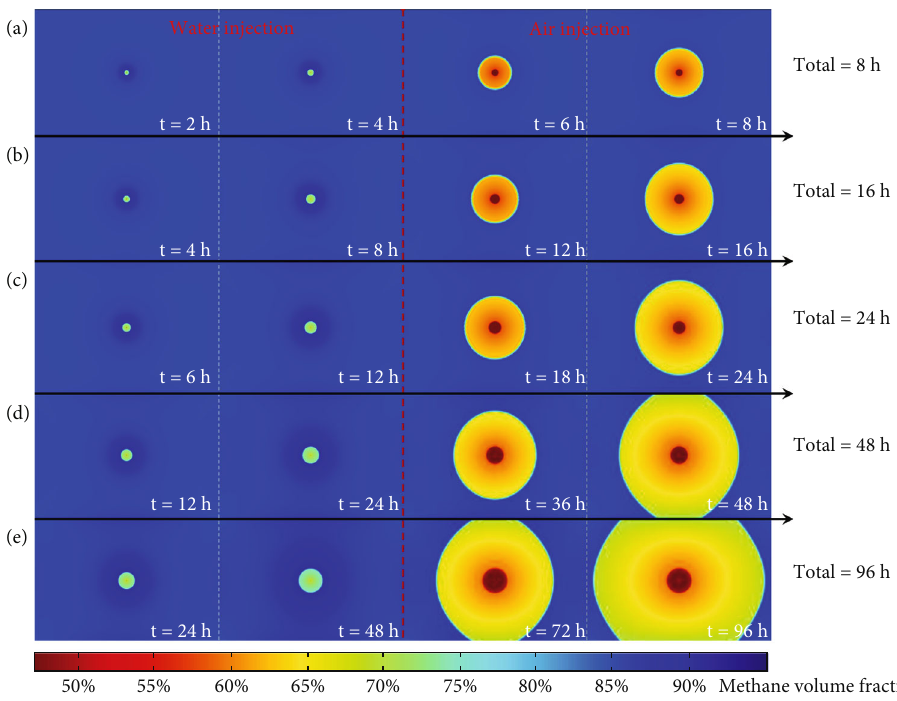
Figure 21: Contour of V